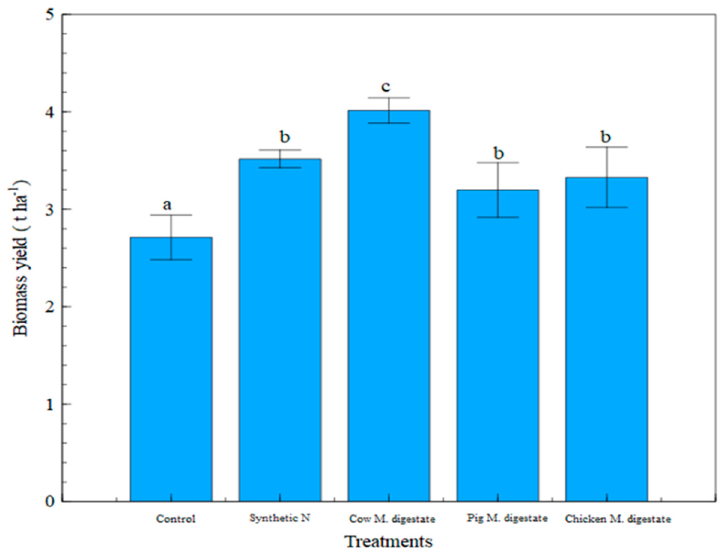
Figure 10. Biomass yield measurement in all treatments in loam soil. Note: treatments with different letters are significantly different at p < 0.05.